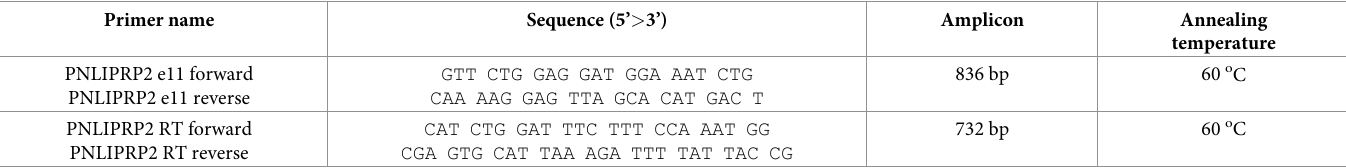
Table 3. Oligonucleotide primers used for PCR amplification of exon 11 of PNLIPRP2 from genomic DNA (e11 primers) and a portion of the PNLIPRP2 coding sequence from pancreatic cDNA (RT primers). Primer